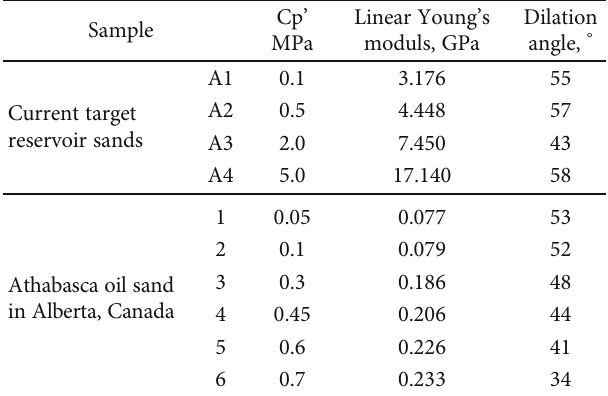
Table 1: Comparison of representative elastoplastic parameters between the Athabasca oil sands and the current target reservoir sands.